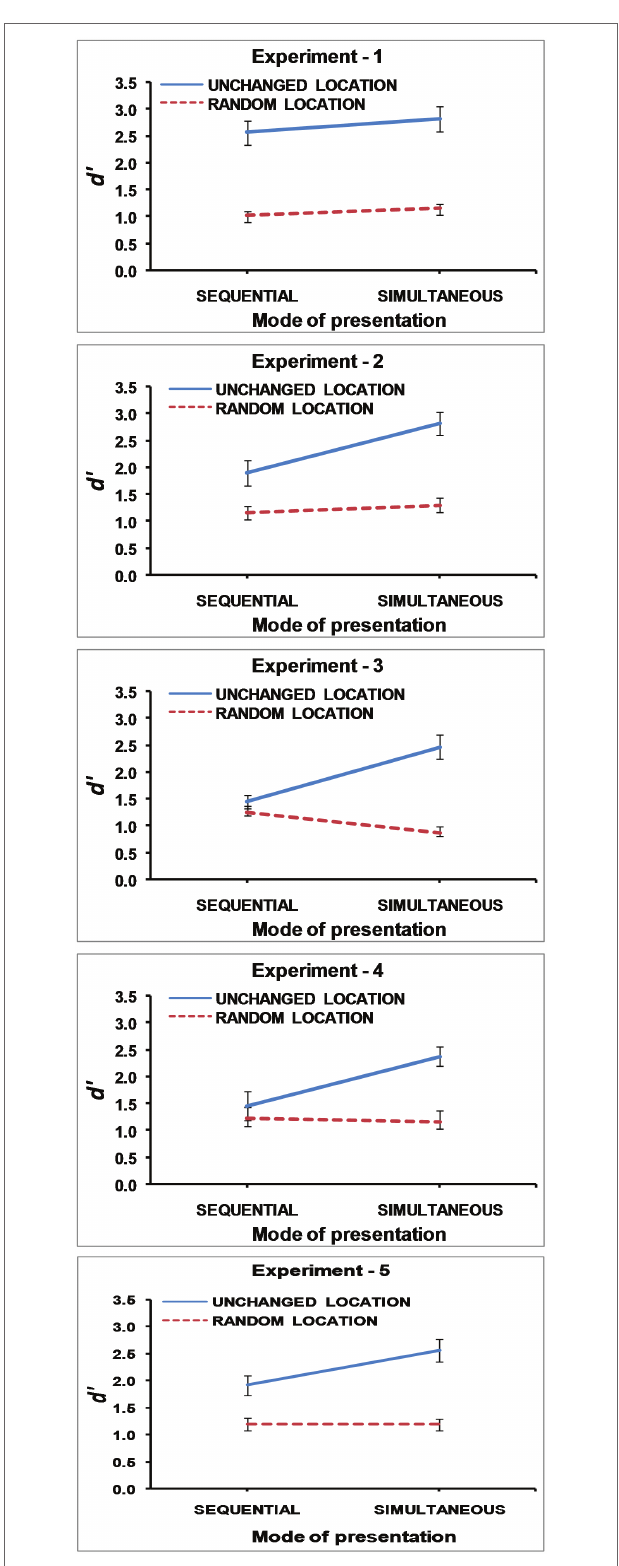
FIGURE 2 | Mean d prime scores in Experiment 1, 2, 3, 4, and 5. The error bars represent ±1 Standard